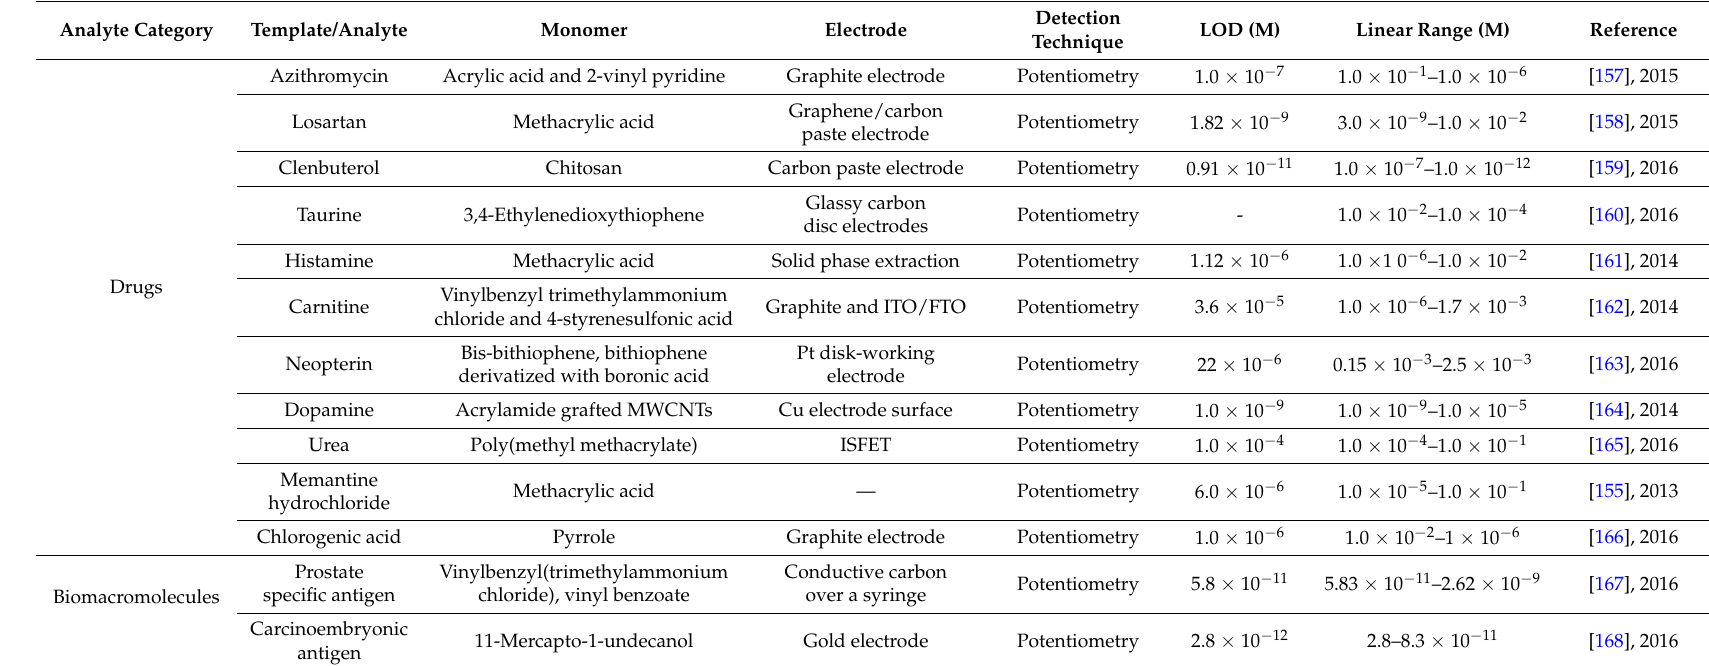
Table 2. Potentiometric transduction for MIP based electrochemical sensors